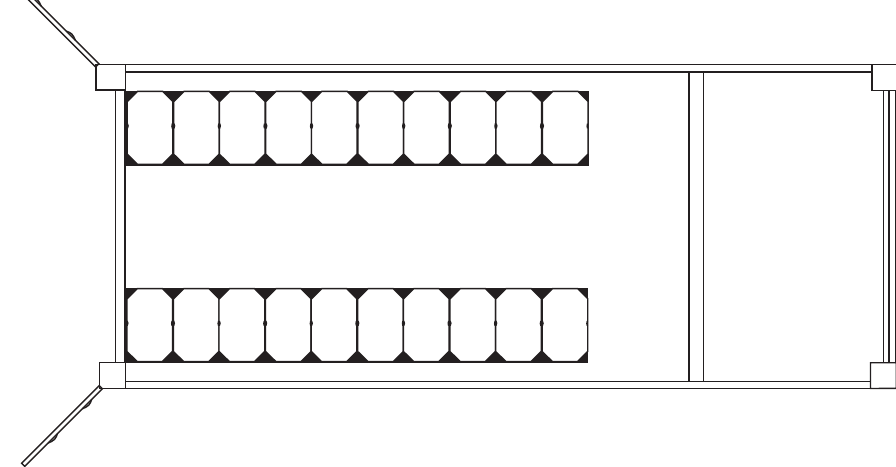
Figure 12. Plane view of a typical arrangement of battery racks in a 20 ft